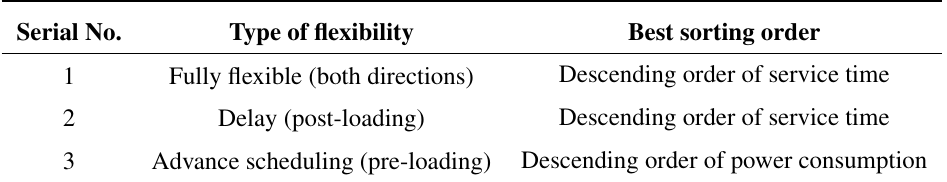
Table 2. Best sorting order: centralized heuristic implementation. Serial